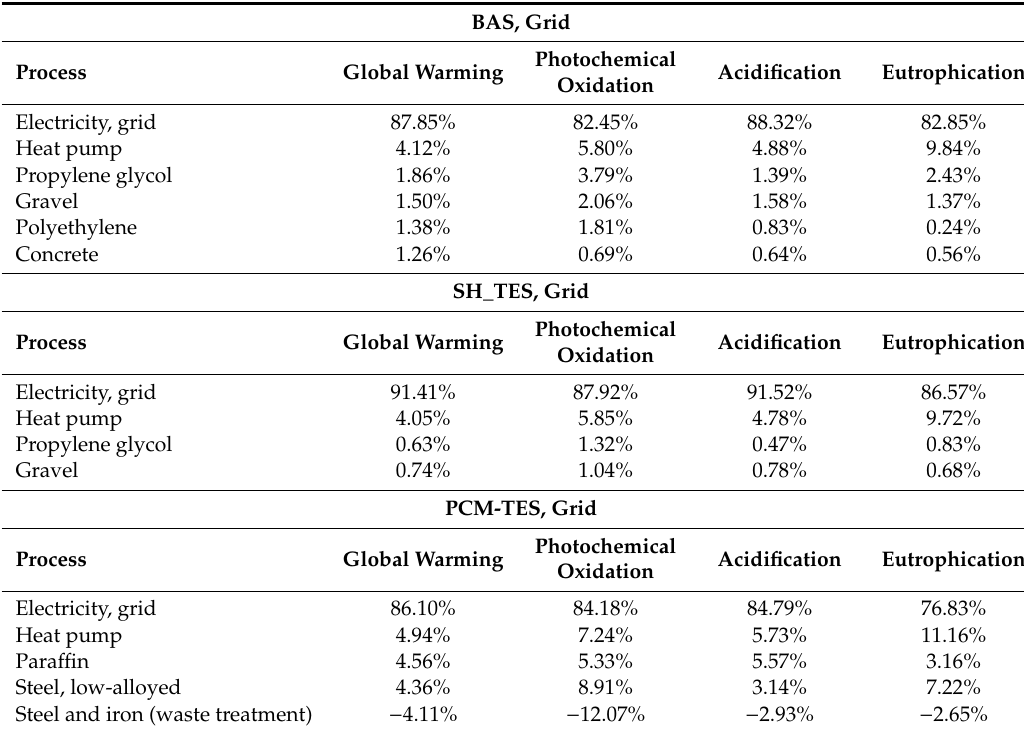
Table 6. Incidence of highest impact processes (electricity from